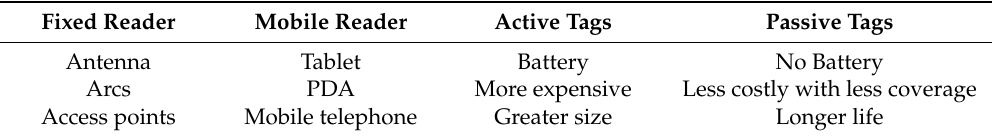
Table 2. Comparison between Readers and RFID tags.